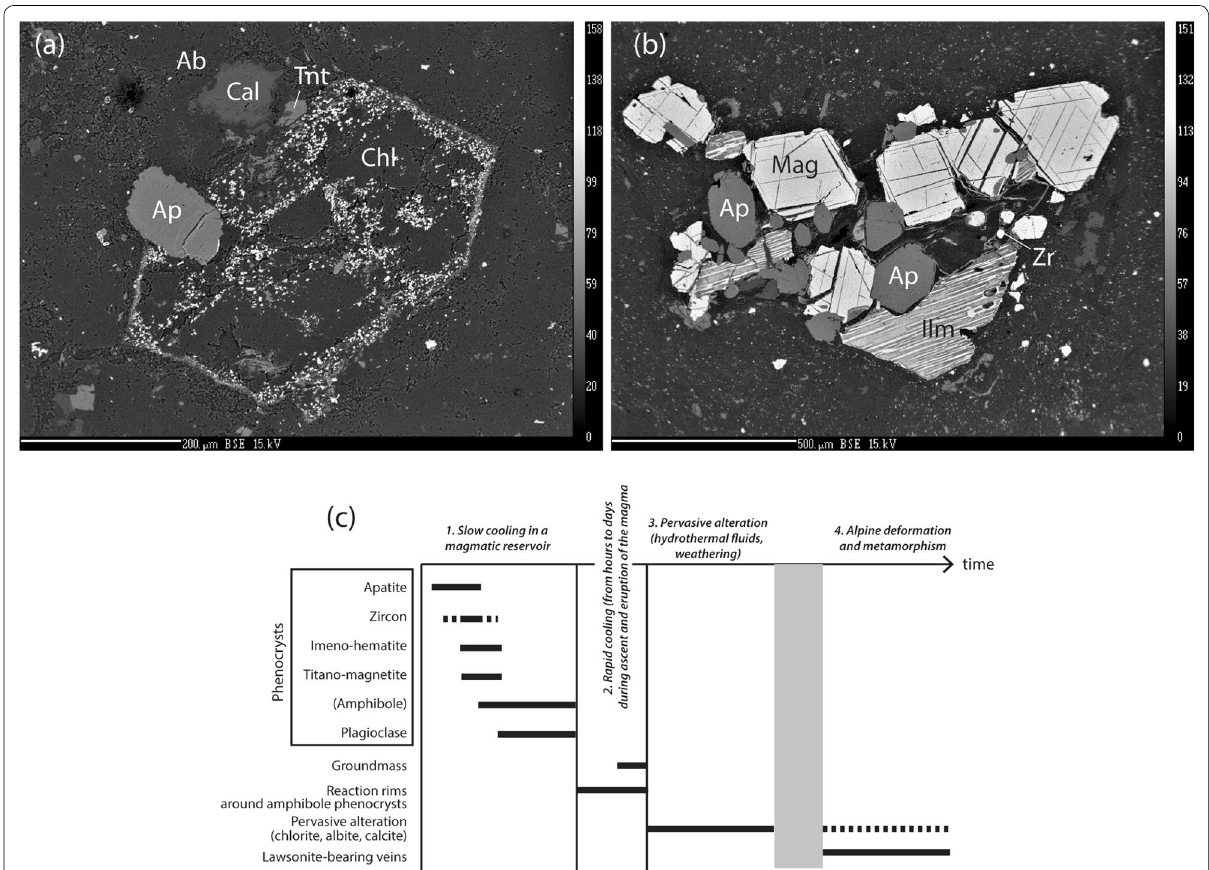
Fig. 5 BSE images of two key textures of the Guil andesite (sample BR 15-01). a Pseudomorph of an idioblastic amphibole crystal, now replaced by a fine-grained aggregate of chlorite, and displaying two key magmatic features, namely a partial inclusion of apatite, and a narrow reaction rim enriched in minute bright crystals of magnetite. b Cluster of FeTi oxides, apatite and a minute zircon grain, illustrating the glomeroporphyritic texture of the volcanic rock. c Sequence of crystallization of the minerals in the studied